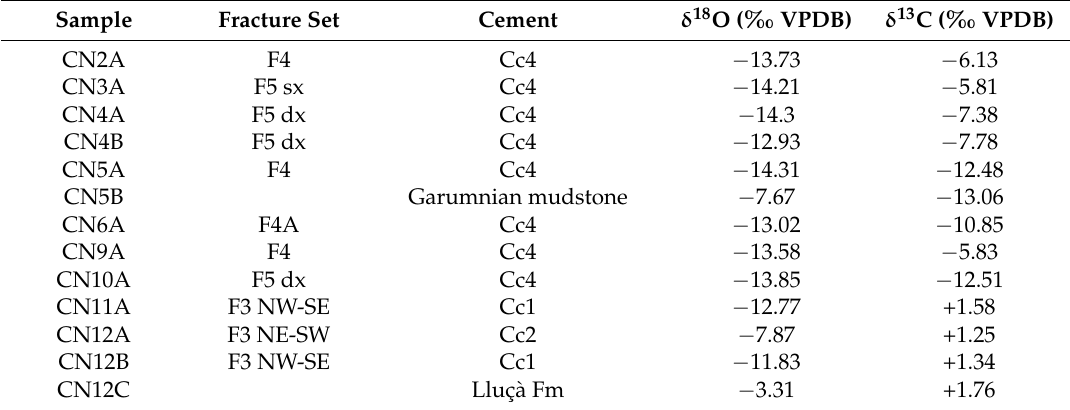
Table 1. δ 18 O and δ 13 C values of the host rocks and related calcite cements. Sx and dx in Fracture Set F5 indicates the main slip movement (left-lateral and right-lateral,